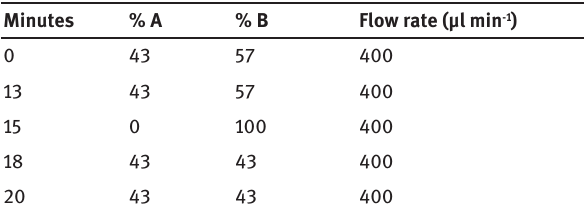
Table 1: A gradient system applied for xanthohumol